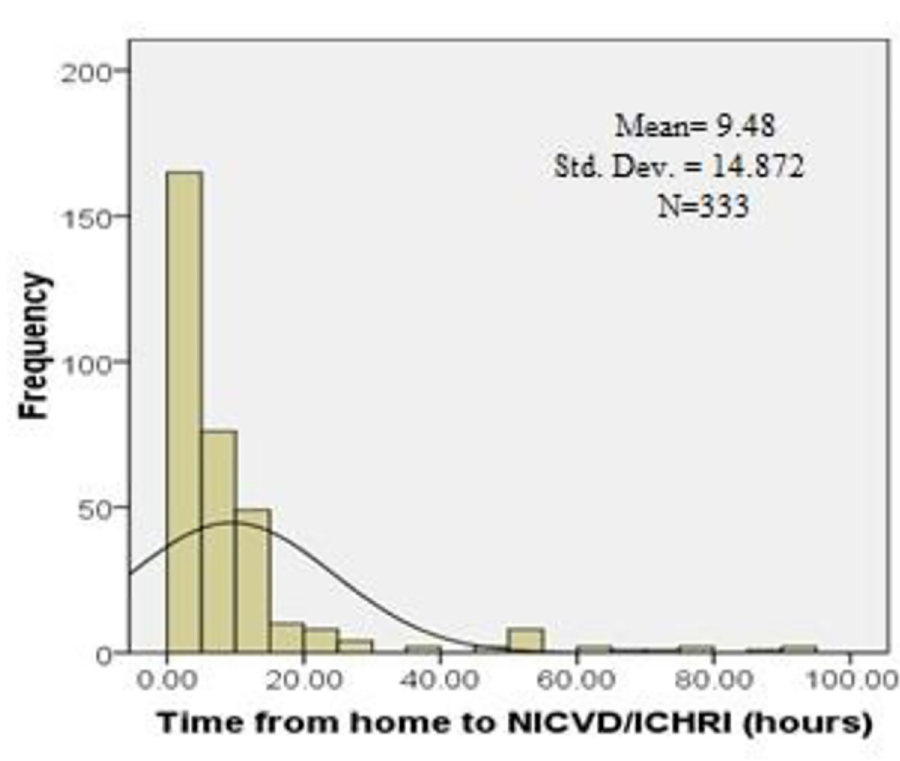
Fig 3. Histogram showing distribution of time to NICVD/ICHRI with right